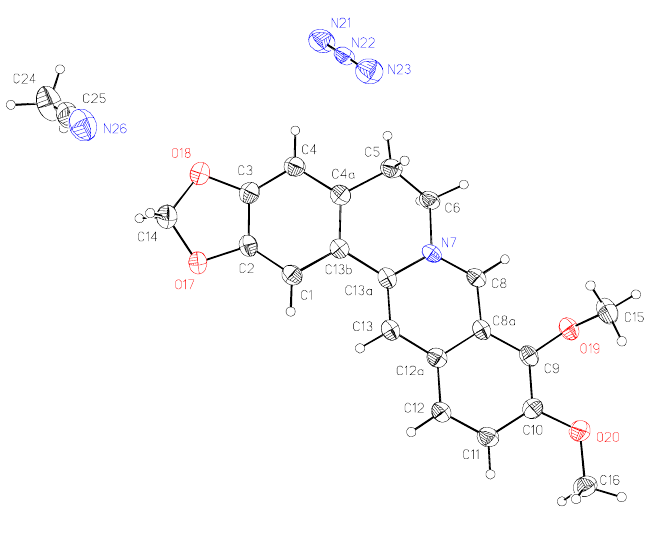
Figure 1 . A perspective view of berberine azide ( 1b )